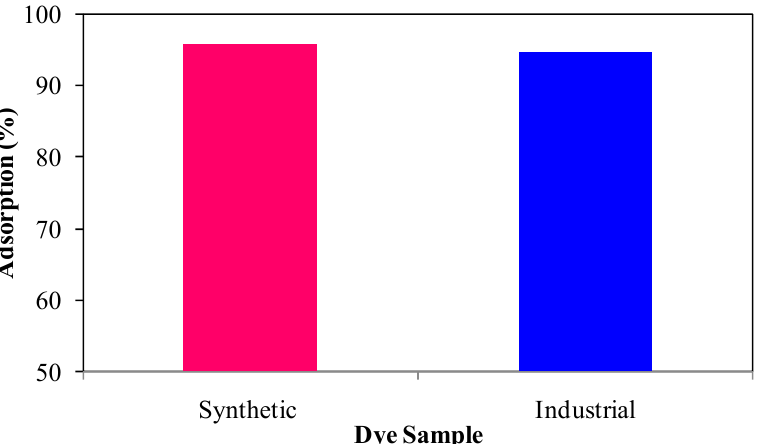
Figure 7. Percent adsorption of RBV-5R dye using sugarcane Bagasse biosorbent for synthetic and industrial dye samples.